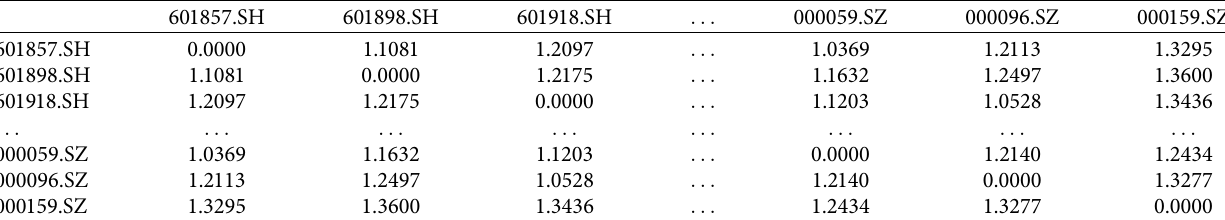
Table 5: Jump distance matrix from October 2016 to April